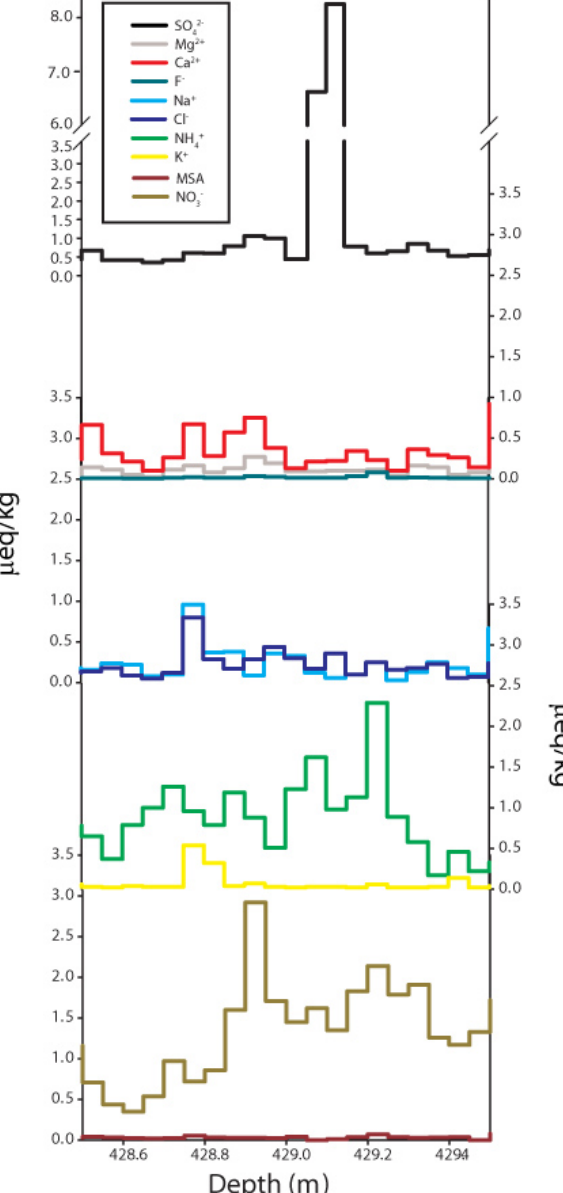
Fig. 3. Major ion concentrations in the GRIP ice core between